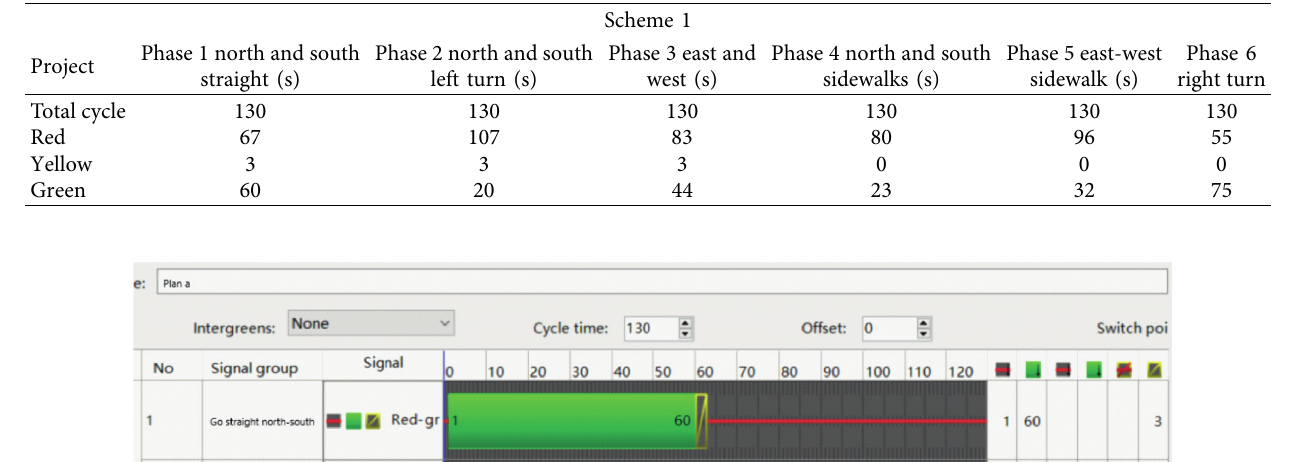
Table 1: Traffic light signal duration of scheme 1.